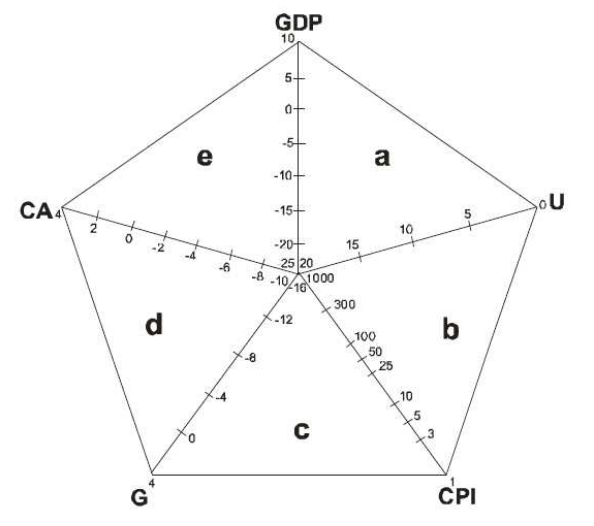
Figure 1. The macroeconomic stability